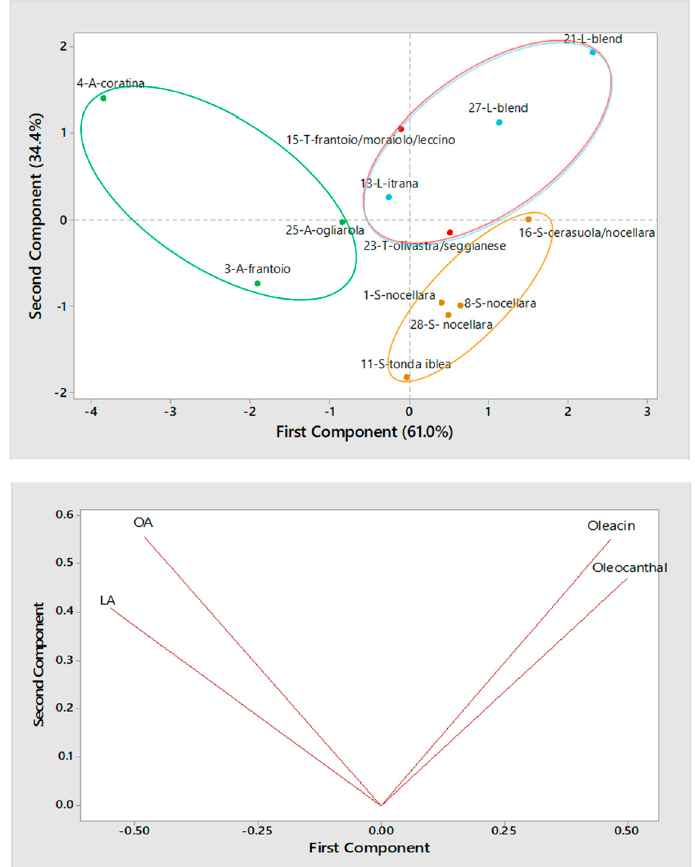
Figure 5. Score plot ( top panel ) and Loading plot ( bottom panel ) referred to the first two components provided by Principal Components Analysis (PCA) based on average normalized peak areas obtained for OA, LA, oleacin and oleocanthal (including the contribution of their carboxylic derivatives, if present) after the RPLC-ESI(-)-FTMS analysis of two replicated extracts for each of 13 Italian EVOOs produced during the 2016/2017 campaign using a three-phase decanter for horizontal centrifugation. Samples are labelled according to number (see Table 1), region (A = Apulia, L = Lazio, S = Sicily, T = Tuscany) and